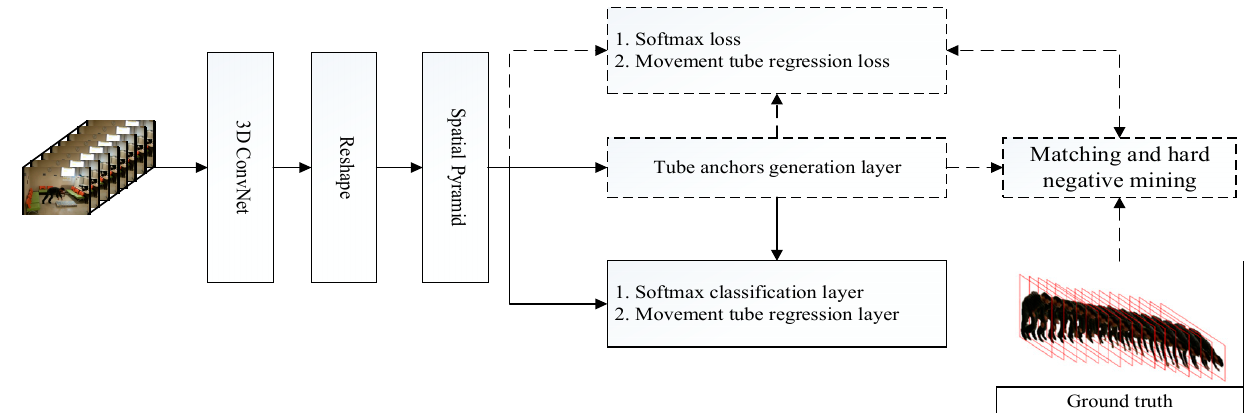
Figure 1. The overview of the proposed method. The model consists of six components: 3D ConvNet, Spatial Pyramid, tube anchors generation layer, matching and hard negative mining, loss layer and output layer. The dotted lines describe the components at training stage. The solid lines describe the components at the inference stage.